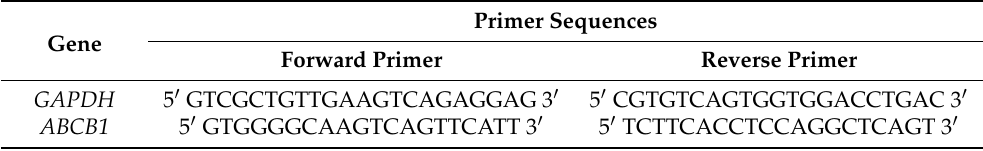
Table 3. Primer sequences for real-time PCR